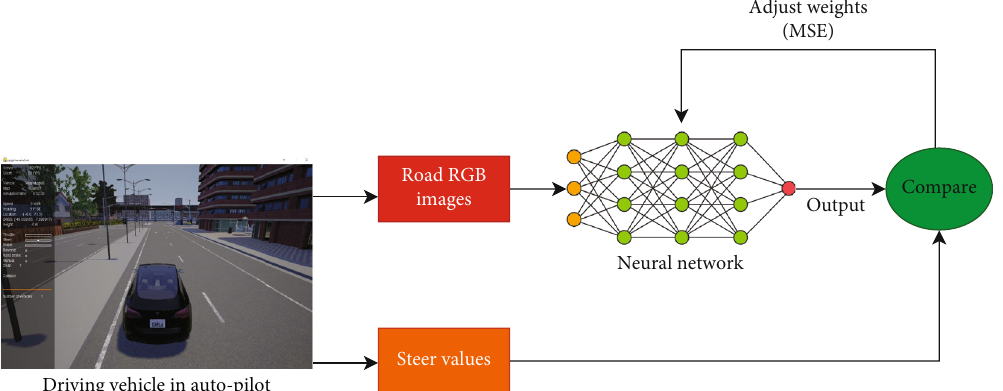
Figure 3: End-to-end training setup.